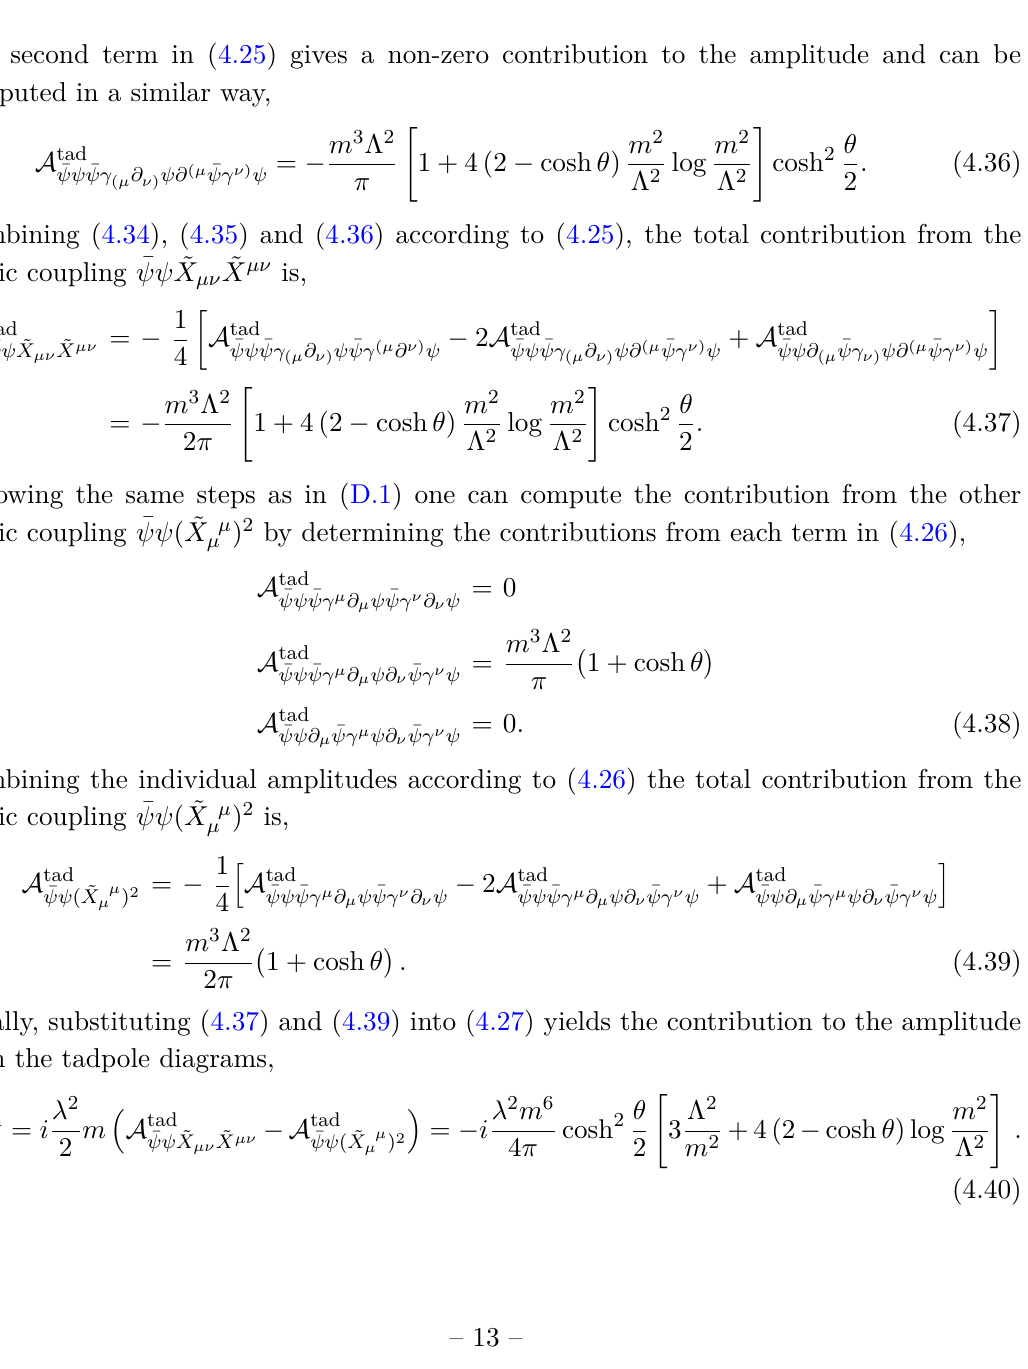
Figure 2 . Tadpole diagram that contributes to the S -matrix at second